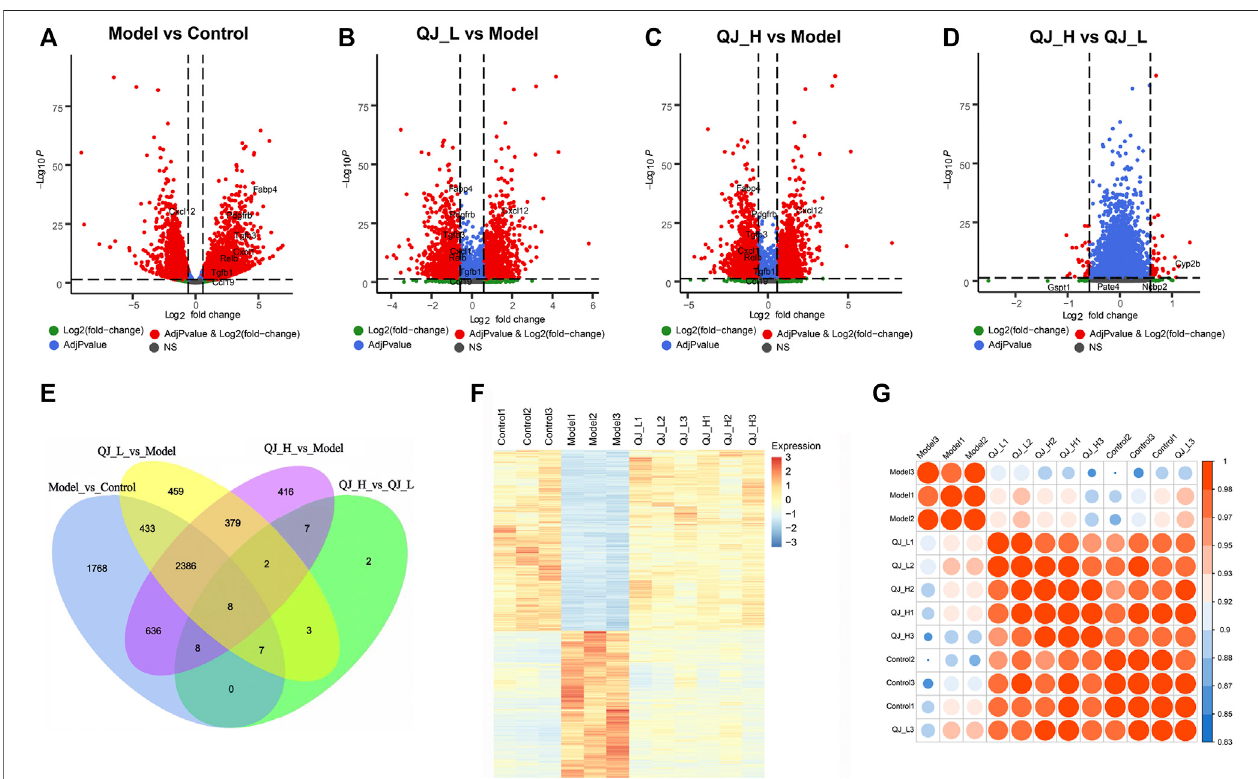
FIGURE4| DEGanalysisofthemRNA-Seq. (A – D) VolcanoplotofdifferentiallyexpressedgenesinQijiaRougandecoction – treatedratswith fi brosis. (A) Modelvs. Control; (B) QJ-L vs. Model; (C) QJ-H vs. Model; (D) QJ-H vs. QJ-L; (E) Numbers of the overlapping genes in different comparisons (Venn); (F) Expression heatmap in the four experimental groups; (G) Corrplot correlation heat map analyses between the four groups.